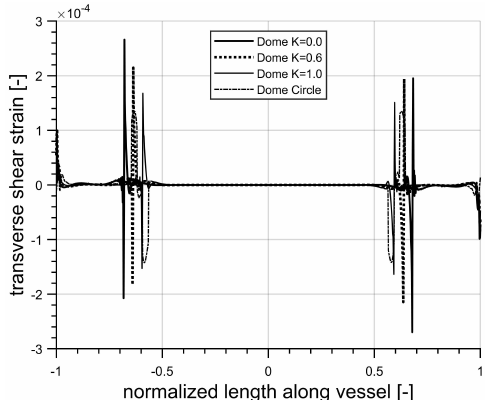
Figure 10. Shearing strain in the composite pressure vessel (CPV).